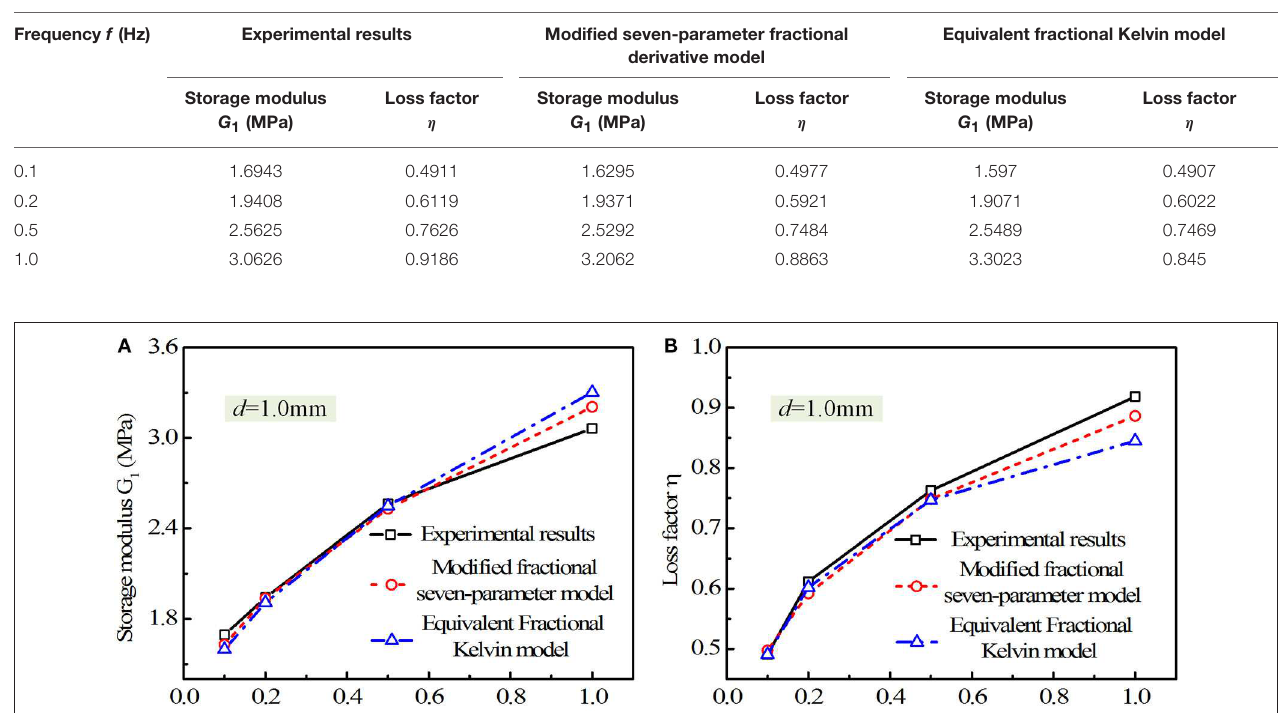
TABLE 3 | Comparison of experimental and numerical results when d = 1.0mm.